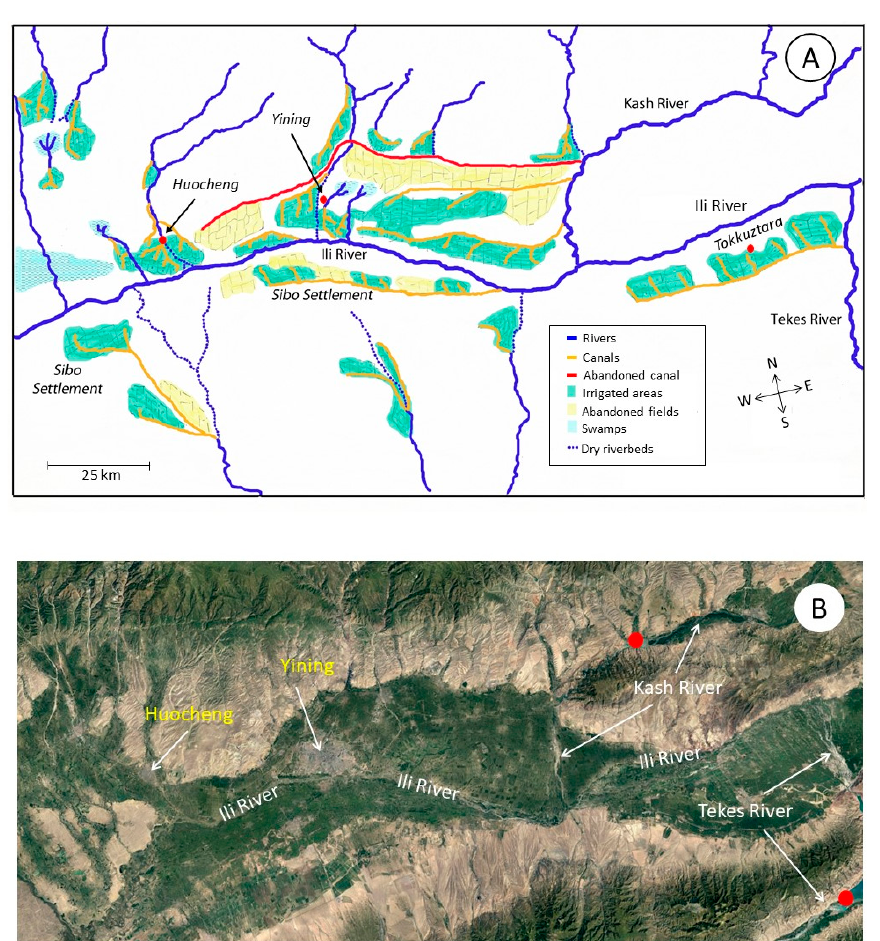
Figure 3. Irrigated areas of the upper Ili River Valley as of ( A ) the early 20th century and ( B ) the early 21st century. ( A ). Simplified and redrawn map based on an early drawing and an older map of the region [42] showing land use categories, Sibo settlements and the oasis at Tokkuztara. Feeder streams, which flow towards the Ili from northerly and southerly directions, are identified. ( B ). Landsat satellite image of the same area in 2018. Two modern reservoirs are visible and marked with red dots. The Ili, Kash and Tekes rivers, as well as the towns of Huocheng and Yining, are labeled in both ( A ) and ( B